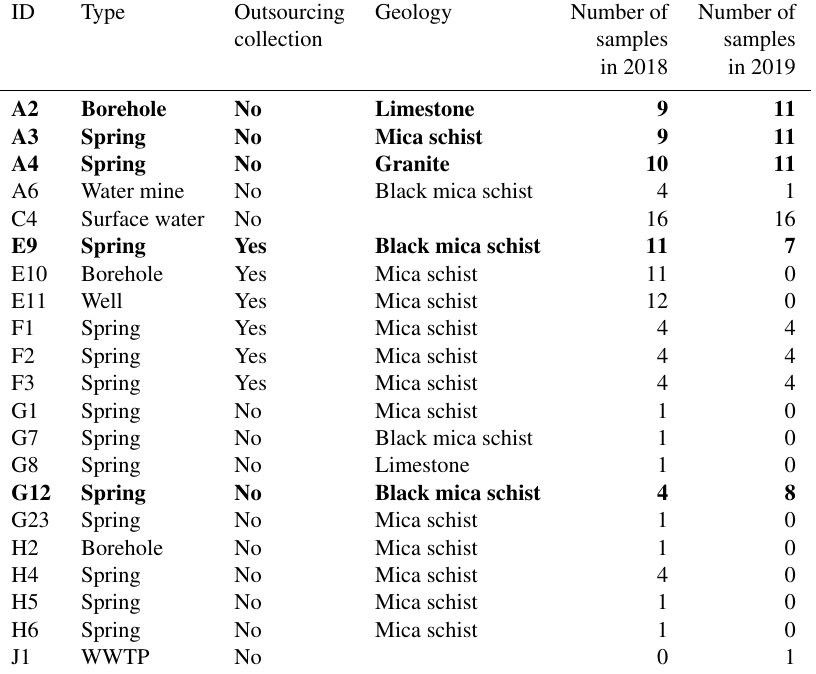
Table 1. Sampling frequency table detailed over both summers. The bold row in the table corresponds to the main groundwater sites, sampled